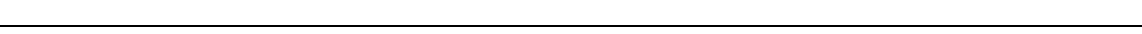
Fig. 3 RNA-seq shows progeny-speci fi c retention of part of transcriptional pro fi le. a Log 10 plot of variance vs normalized (norm) count for all genes detected in fi broblast- and MAB-MiPs. Data points depict average values of detected genes. Genes associated with pluripotency and with epigenetic/ genetic control on muscle mesoderm are highlighted. b Unbiased clustering of all MiP and parental iPSC samples analyzed by RNA-seq. c PC analysis of all samples reveals stage-speci fi c, progeny-speci fi c clustering. d GO analysis (Biological Process) of DE genes between fi broblast- and MAB-derived cells reveals that > 79% GO terms are overlapping between MiP and iPSC stages. Sub-categorization of overlapping GO terms is charted at the right. e Heatmap ( z -test) of DE genes (threshold, > 10 norm counts) discriminating fi broblast- and MAB-MiPs. f Volcano plot of fold change vs p -value of all DE genes at MiP stage (threshold, P = 0.05, dashed line). Left side of the chart, all genes and highlighted candidates enriched in fi broblast-MiPs; right side, genes and candidates enriched in MAB-MiPs. g Log 2 chart of fold change at MiP stage vs at iPSC stage of signi fi cantly DE genes (threshold, P < 0.05 at MiP stage). Light blue dots depict genes upregulated in fi broblast-iPSCs and fi broblast-MiPs, while light red dots depict upregulated genes in MAB-iPSCs and MAB-MiPs. Circled dots represent the candidates, as identi fi ed in f , with conserved DE trend. h Quantitation of results obtained from bisul fi te sequencing of upstream CpG islands of selected gene shortlists in fi broblast- and MAB-MiPs, and their parental iPSC and somatic cells. Data is depicted as heatmap ( z -test) of average percentages of methylated CpGs ( n = 3 replicates/cell clone). i Quantitation of results obtained from ChIP-qPCR experiments analyzing fi broblast- and MAB-MiPs, and their parental iPSC and somatic cells. H3k9me3, repressive mark; H3k4me2, H3k27ac, permissive marks. Data is depicted as heatmap ( z -test) of average percentages of IP-enriched vs total input DNA ( n = 3 replicates/cell clone). f-, fi broblast-derived, DE,